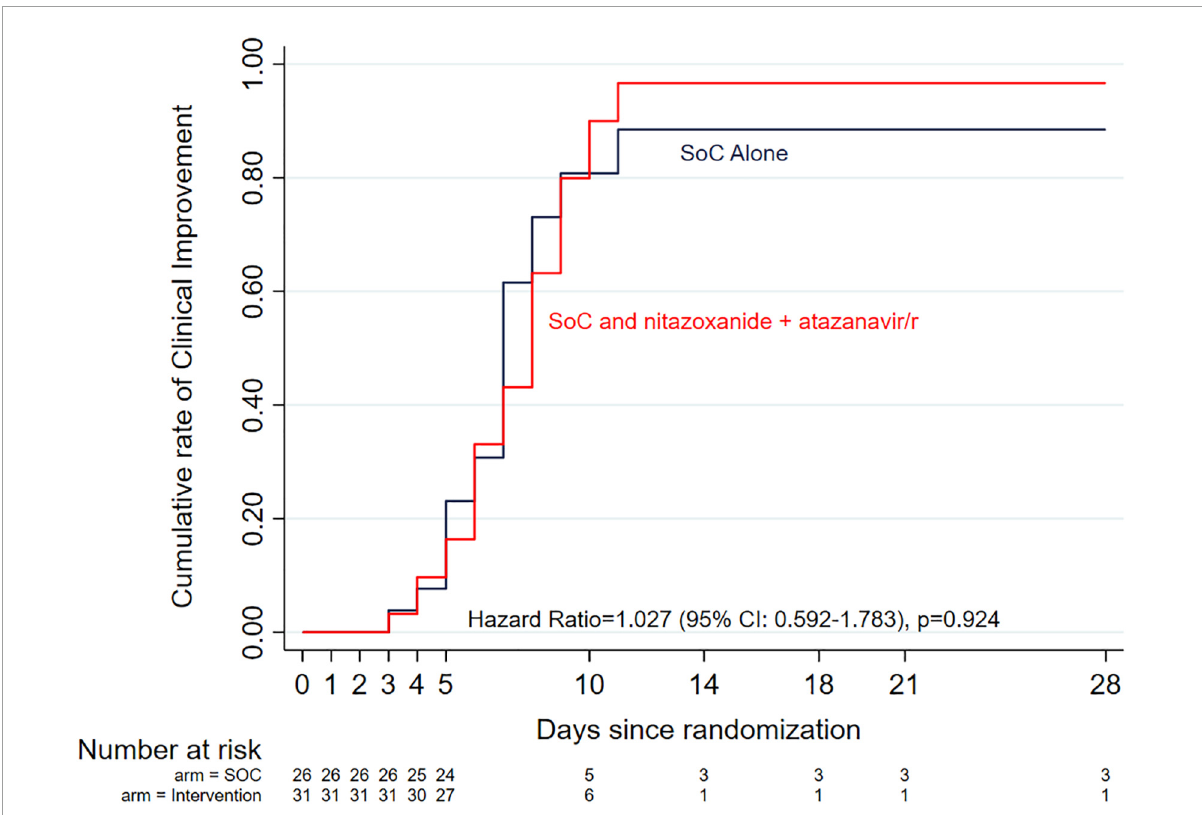
FIGURE2 Kaplan-Meier curves of time to clinical improvement (defined as a drop of 2 levels on the 1–10 ordinal scale) by study arm. There was no difference between the two arms (7 days in the standard of care arm alone vs. 8 days in the standard of care plus intervention arm). The Cox proportional hazards model adjusted hazard ratio was 0.898 (95% Cl: 0.492–1.638, p = 0.725) after adjusting for potential co-founders, including randomization stratification variables, age and